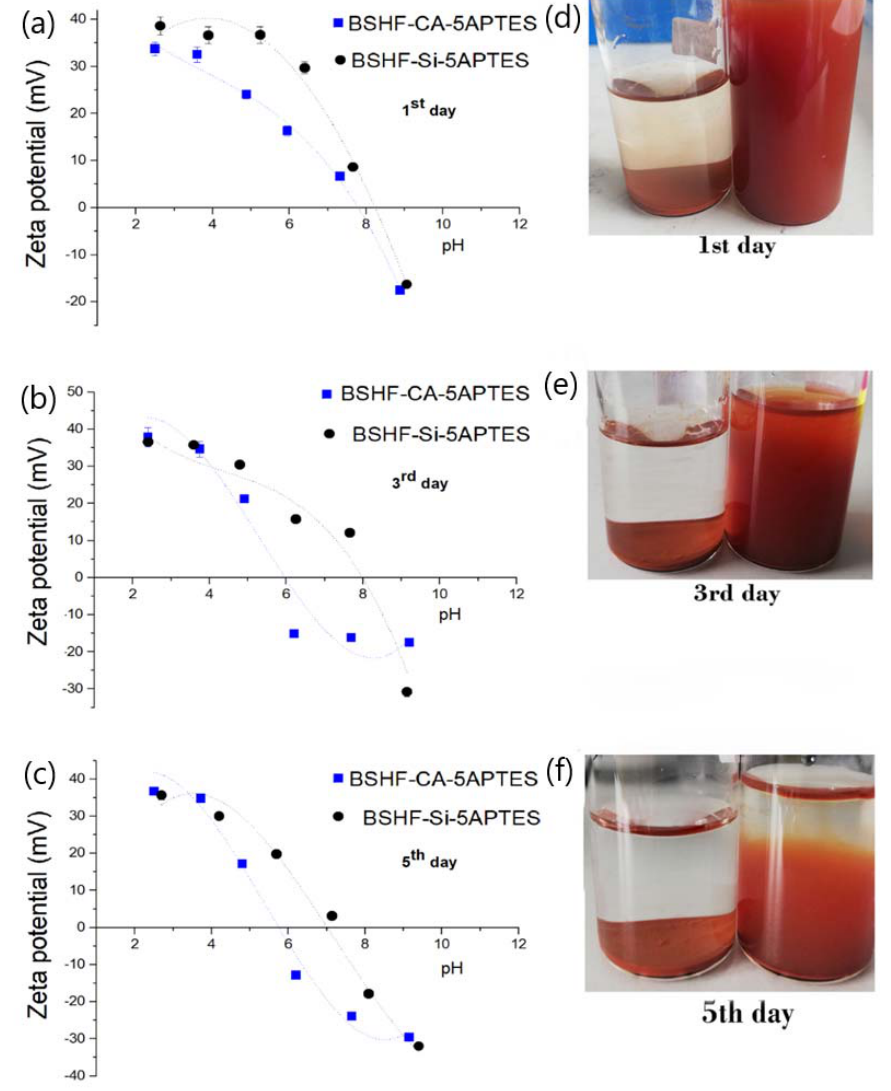
Figure 3. Zeta potential vs. pH of samples BSHF-CA-5APTES and BSHF-SI-5APTES measured: ( a ) immediately after washing (1st day) and on the ( b ) 3rd and ( c ) 5th day after synthesis. The fitting lines in panels ( a – c ) are only presented as a guide for the eye. Data were fitted by a 3rd order polynomial fit function. Photos of the measured dispersions were taken on the ( d ) first, ( e ) third, and ( f ) fifth day of synthesis. The vials on the left are sample BSHF-CA-5APTES, and the vials on the right are sample BSHF-Si-5APTES.